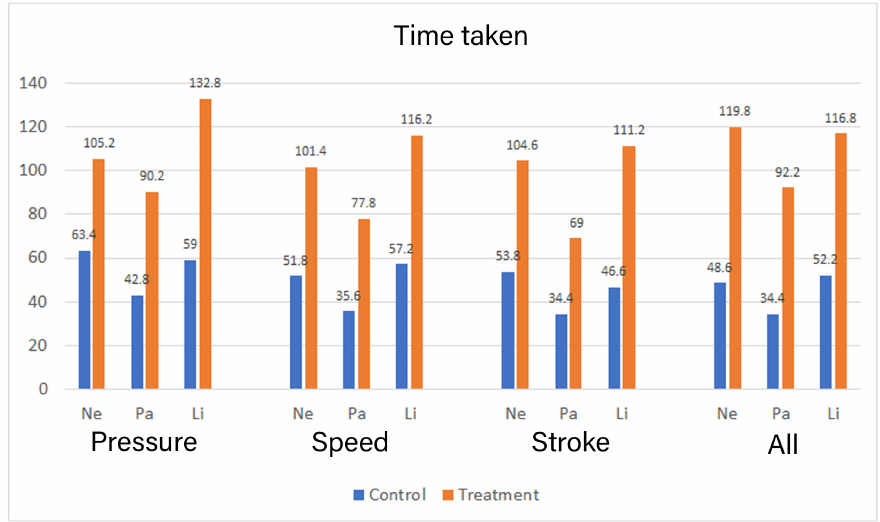
Figure 8. Time taken by the two groups [in